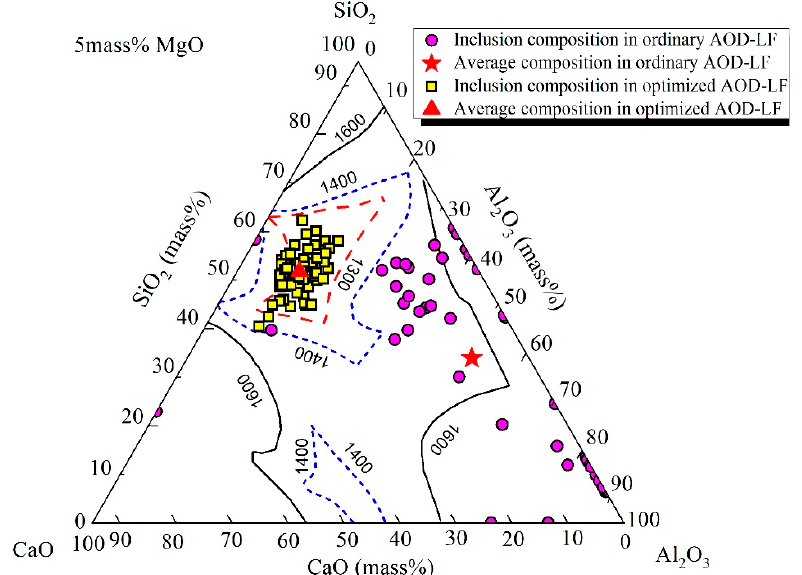
Figure 19. Composition distribution of inclusions in casting slab on C a O-SiO 2 -Al 2 O 3 -MgO phase diagram before and after optimization of AOD and LF process.